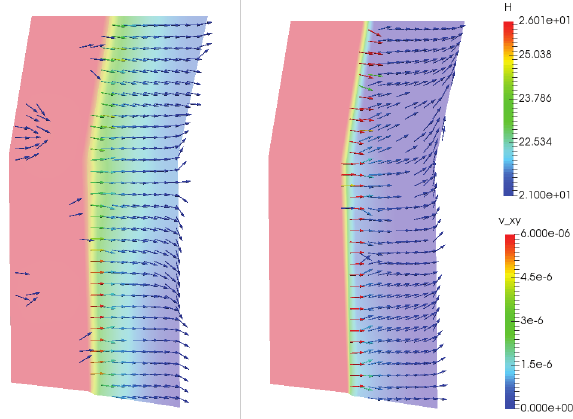
Figure 12: Seepage rate vectors on the 15th day of a flood, in the gravel layer for the case of the shorter diaphragm wall (left) and longer diaphragm wall